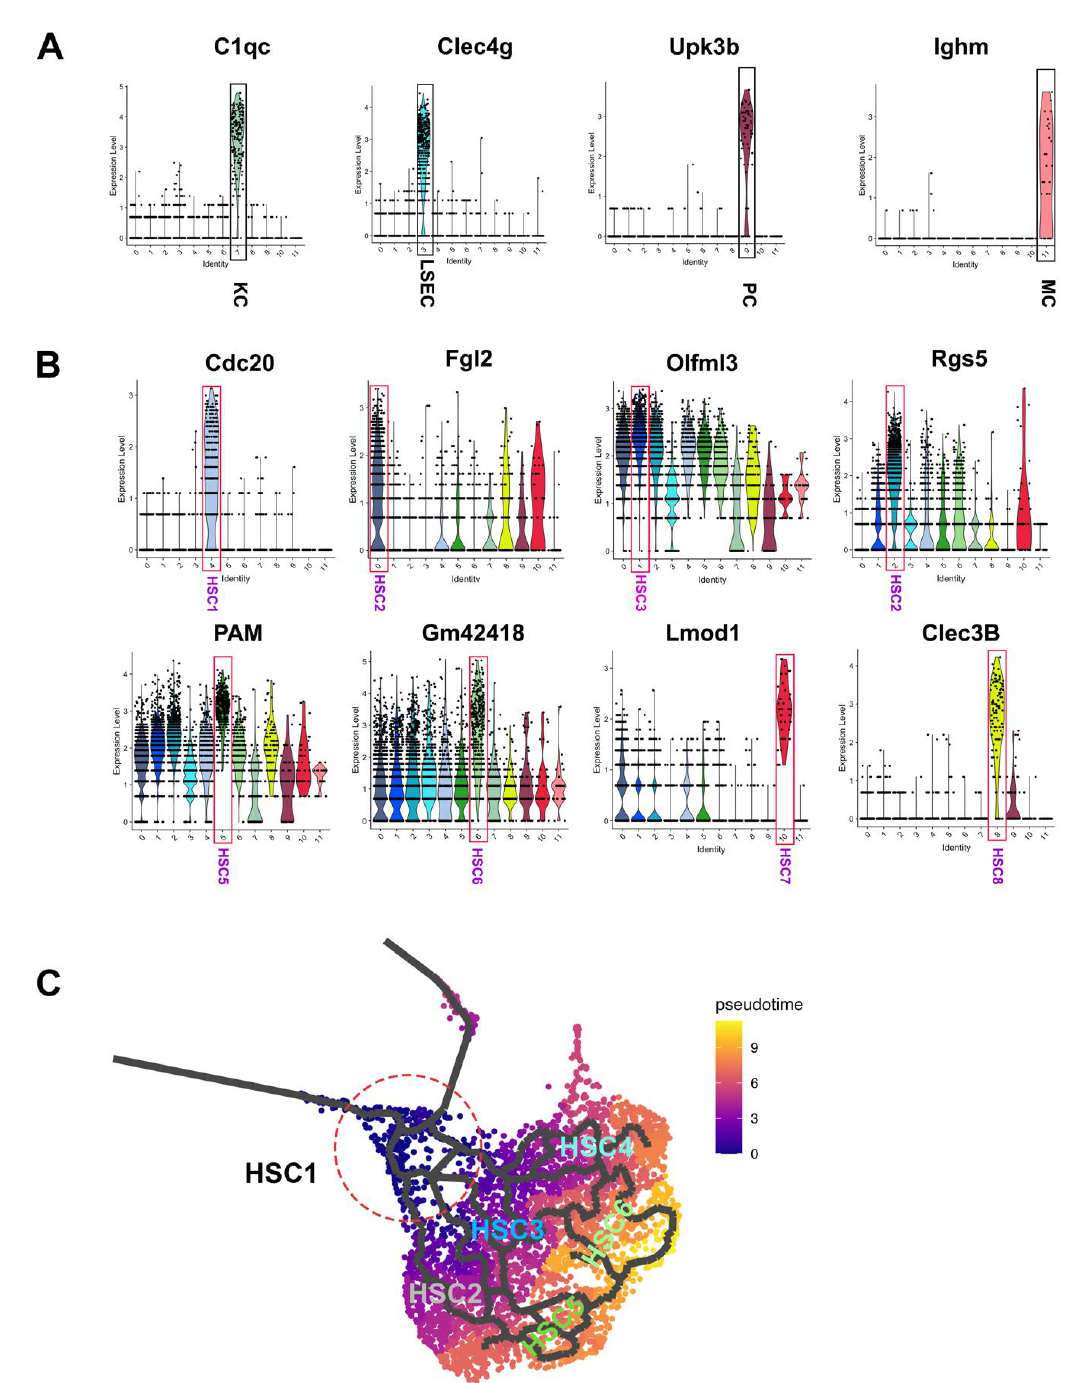
Figure 2. Heterogeneity of HSCs in CCl 4 treated mouse liver. ( A ) Violin plot showing the expression pattern of marker genes to define non-HSC clusters, such as KC, LSEC, PC, and MC. ( B ) Violin plot showing the expression level of the representative marker genes in HSC clusters. ( C ) Monocle analysis overlayed all the HSCs onto UMAP, showing the transformation trajectories of single-cell HSC clusters from CCl 4 treated mouse liver. HSC1 was used as root linage for analysis. Pseudo time is defined on the right.